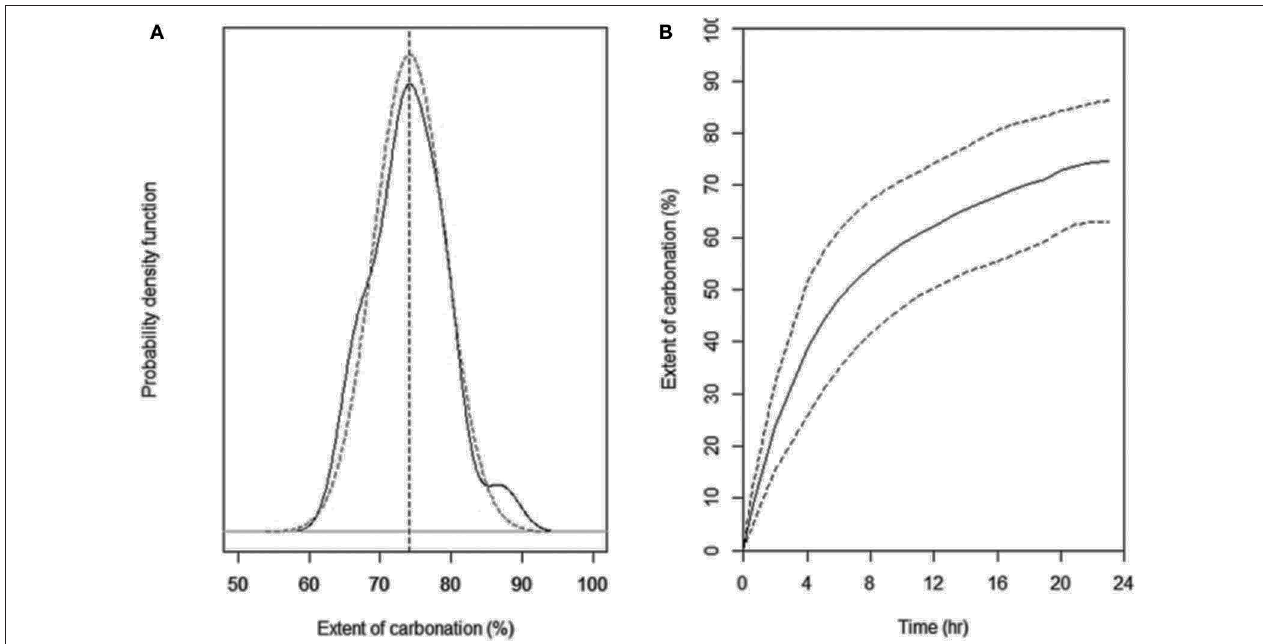
FIGURE 9 | Statistical analysis (21 observations in total) of the measured extent and rate of carbonation for the favorable carbonation conditions of Ni-slags. (A) Measured (solid line) and fitted (dotted line) density distribution function of the extent of carbonation (B) Measured rate of carbonation (dotted lines give the 95% confidence